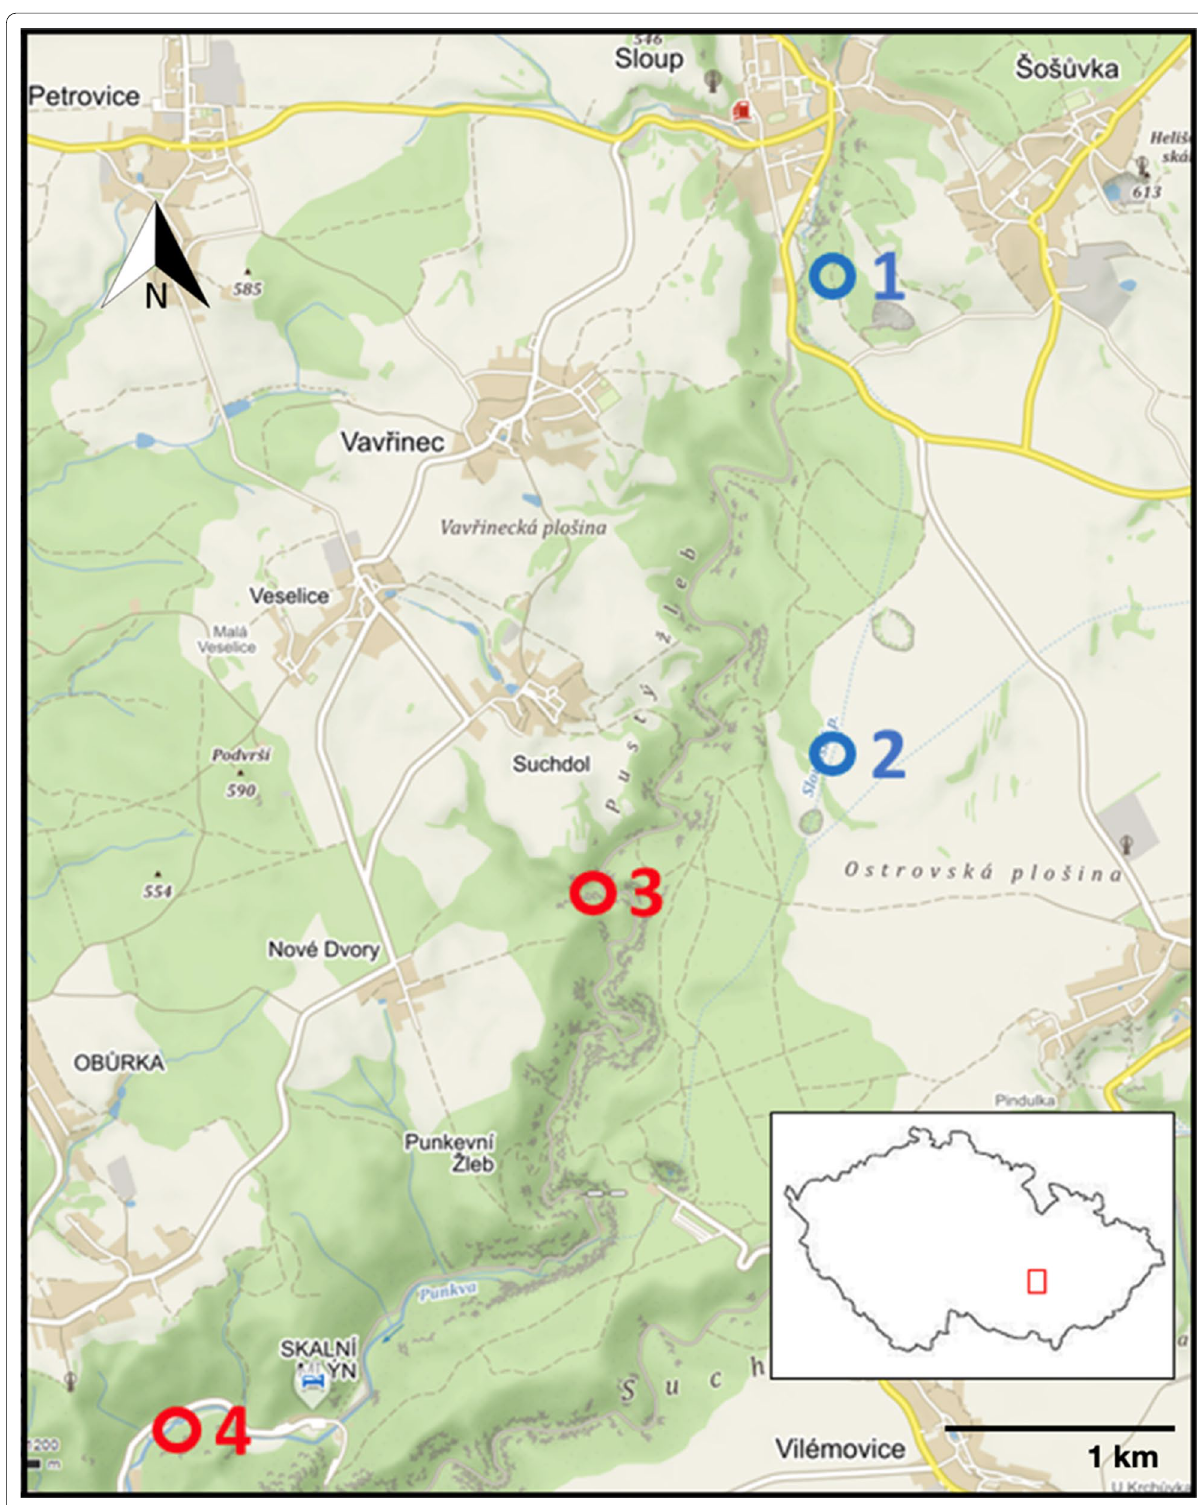
Fig. 1 Location of sampling sites. Soil samples were collected from both cave (sites 1 and 2 corresponding to the Sloupsko‑Šošůvské Caves and Amatérská Cave, respectively) and surface (sites 3 and 4). The earthworm A. chlorotica was sampled in sites 1 and 4, while A. rosea was sampled in sites 2 and